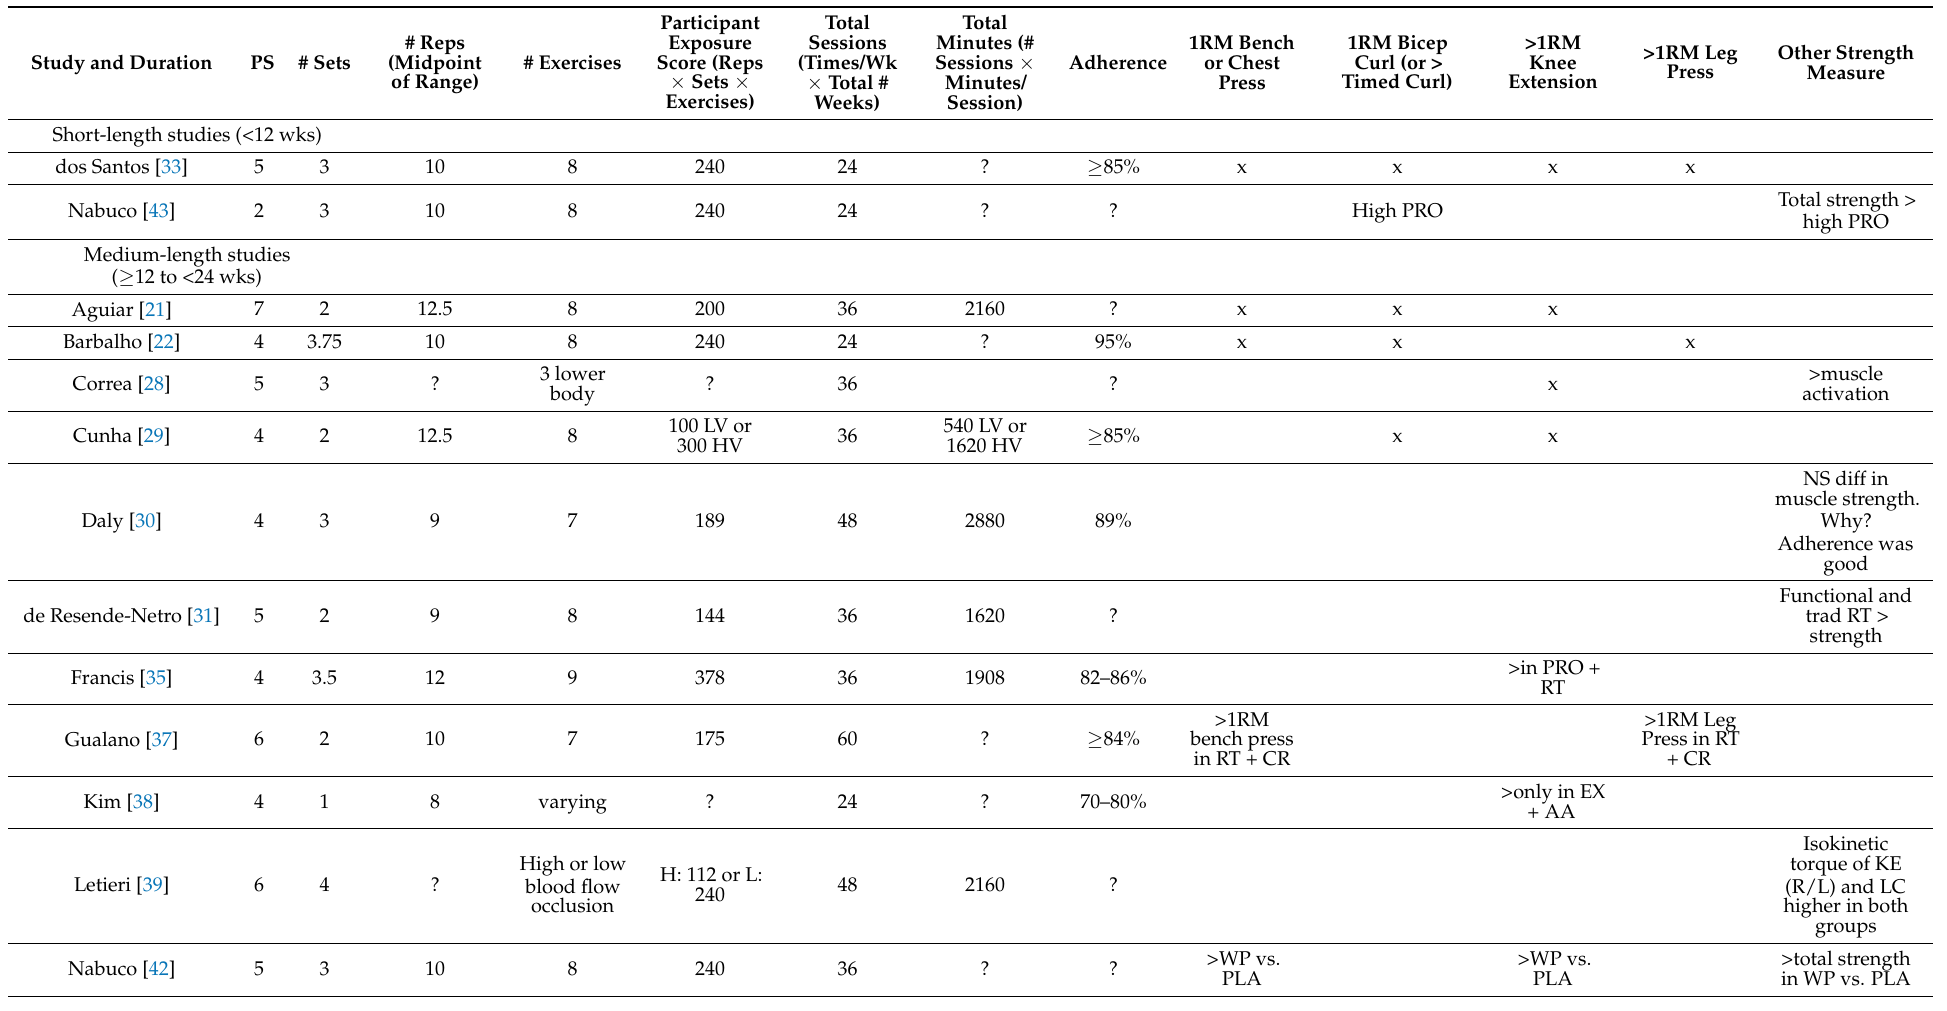
Table 5. Summary of impact of participant exposure, study duration, and adherence in studies that measured muscular strength in older